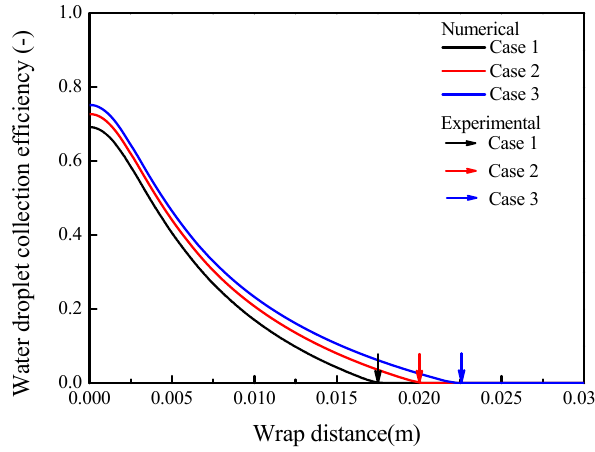
Figure 10. Numerical and experimental results of the water droplet impinging limits.